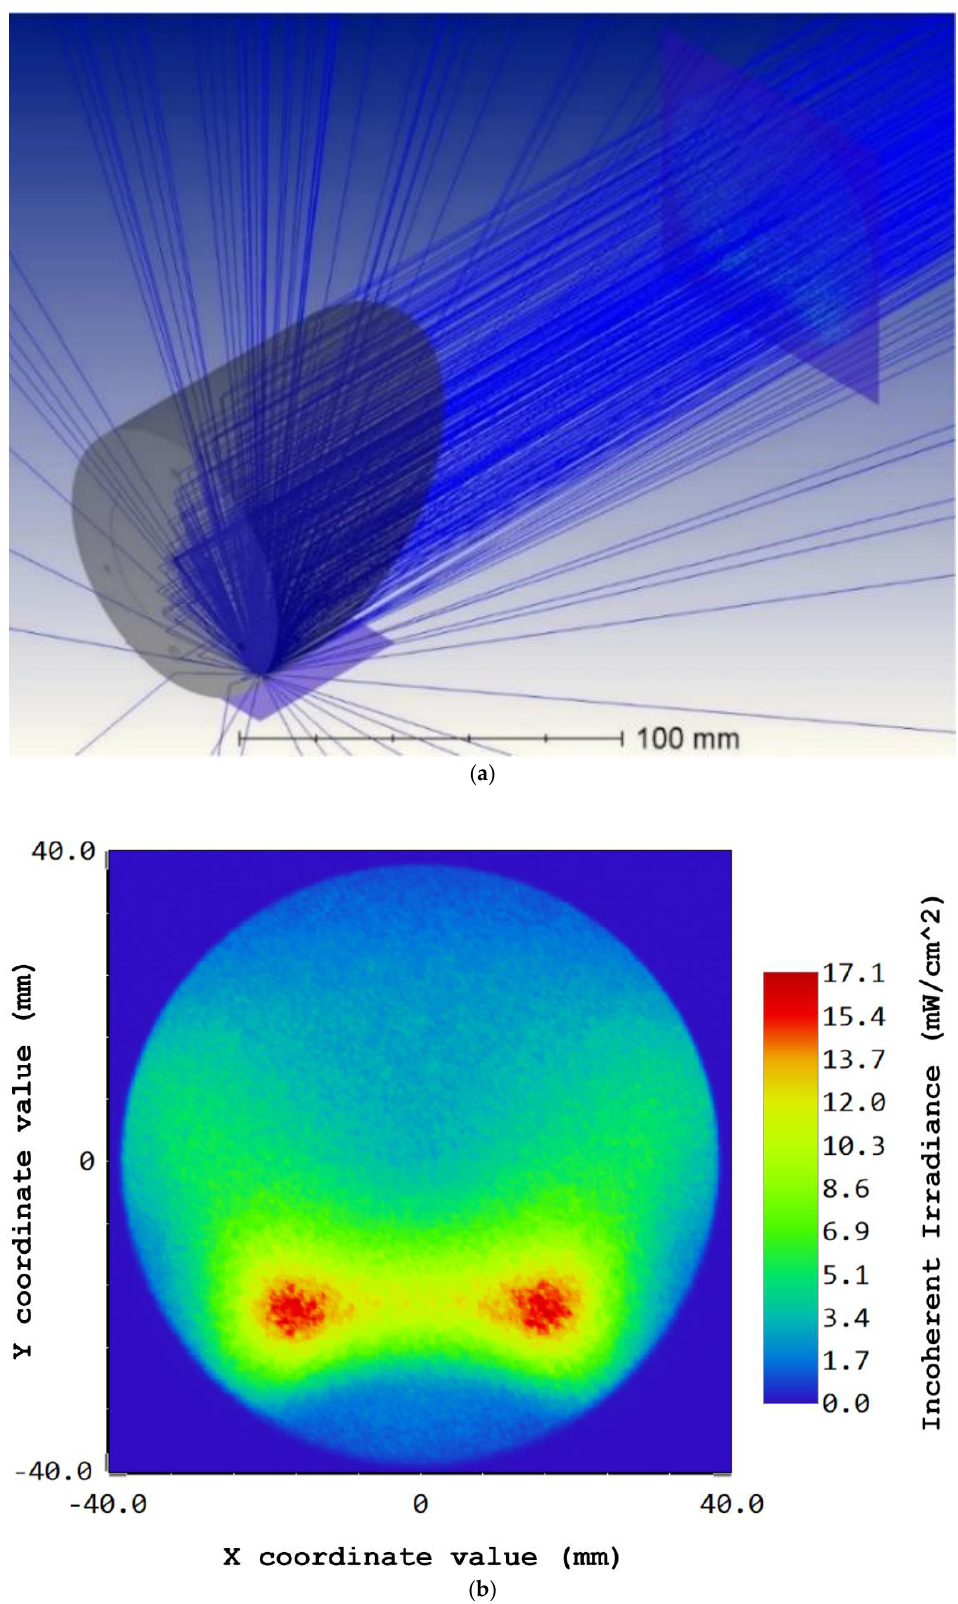
Figure 9. ( a ) Basic optical setup at the transmitter ( b ) laser beam at the enclosure’s aperture.